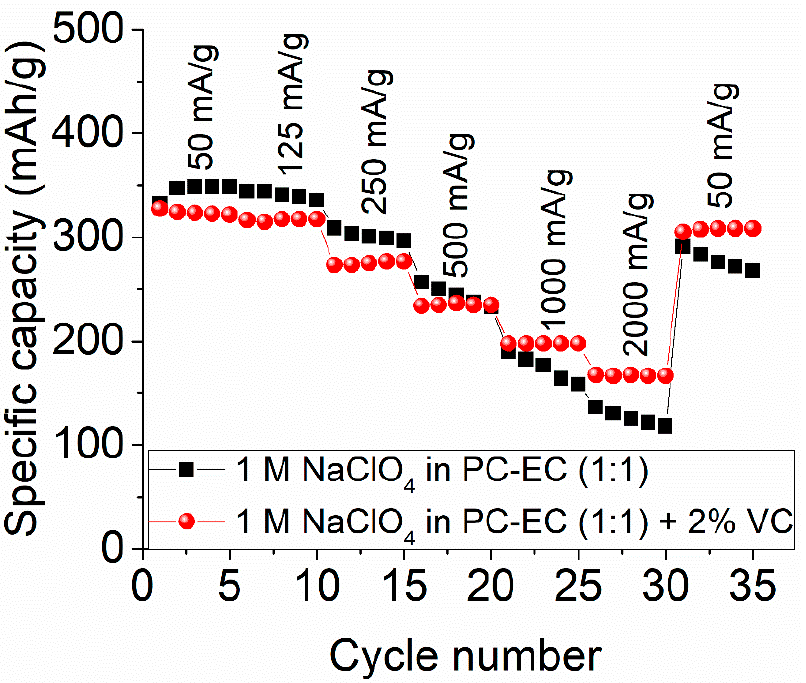
Figure 8. Specific capacity vs. cycle number of Ge microrods upon cycling in different electrolytes at various current densities.